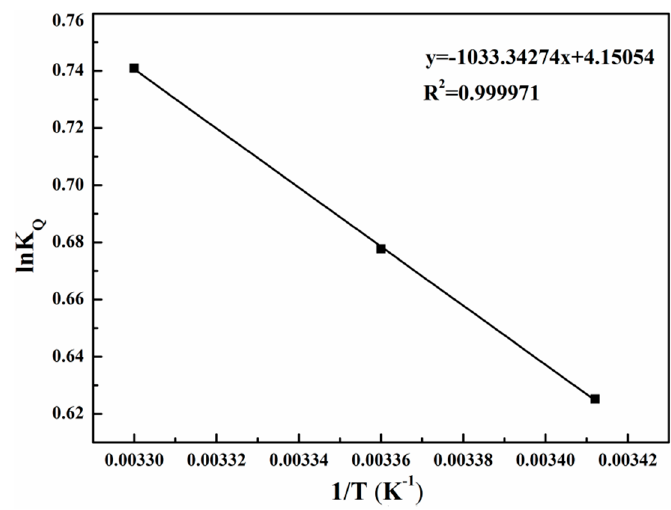
Figure 6. E ff ect of temperature on gold adsorption. Figure 6. Effect of temperature on gold adsorption. Table 6. Related thermodynamic parameters of gold adsorption